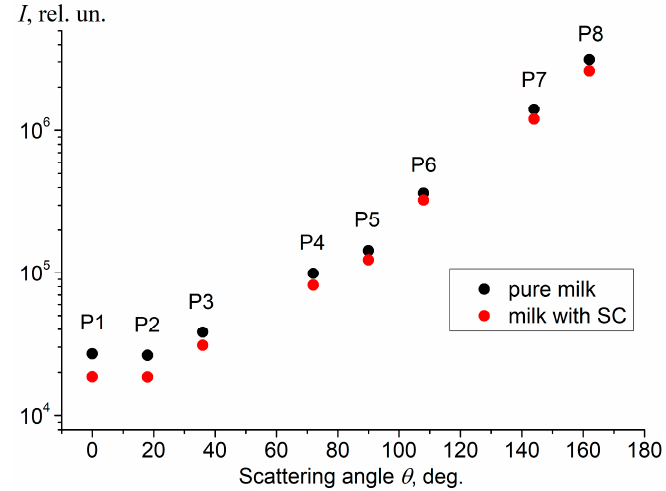
Figure 7. Scattering indicatrix measured for milk samples having a nominal fat percentage of 1.5%: without large-scale impurities (black circles), with the addition of somatic cells (SC) at a concentration level of 10 6 cm − 3 (red circles). Milk flow velocity in the tube is zero. The temperature is 20 °C. Laser wavelength is 532 nm.